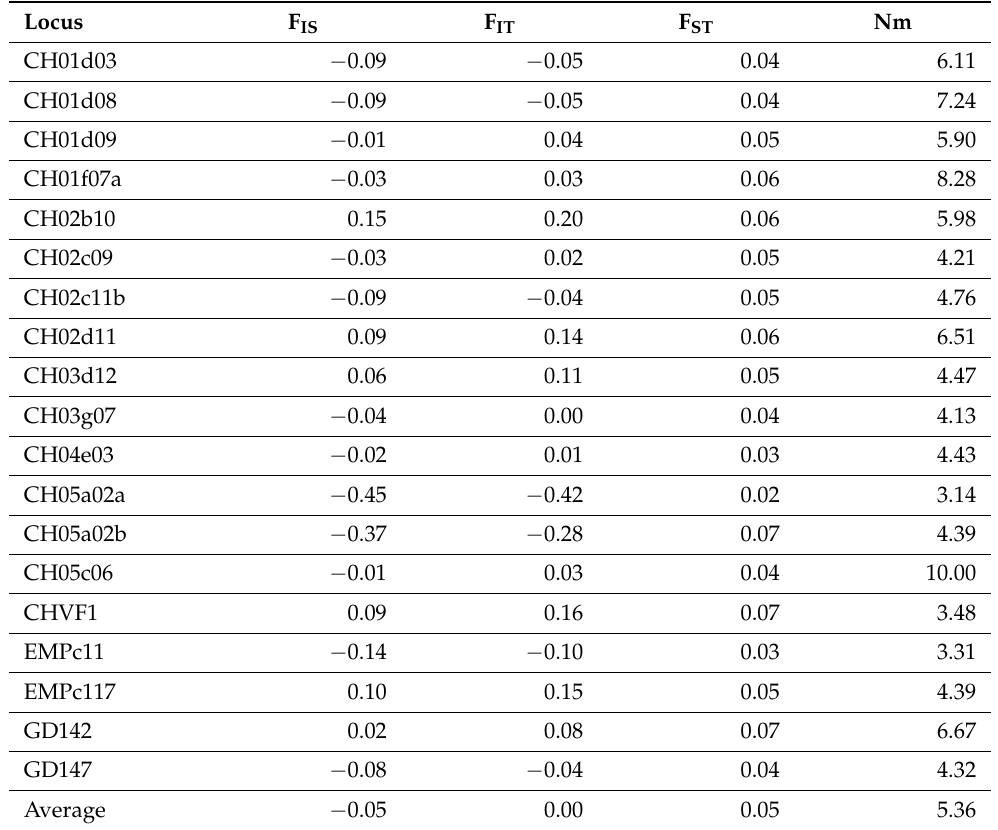
Table 2. Inbreeding coefficient (F IS ), total consanguinity coefficient (F IT ), fixation index (F ST ) and number of migrants (Nm) per locus in 192 diploid pear